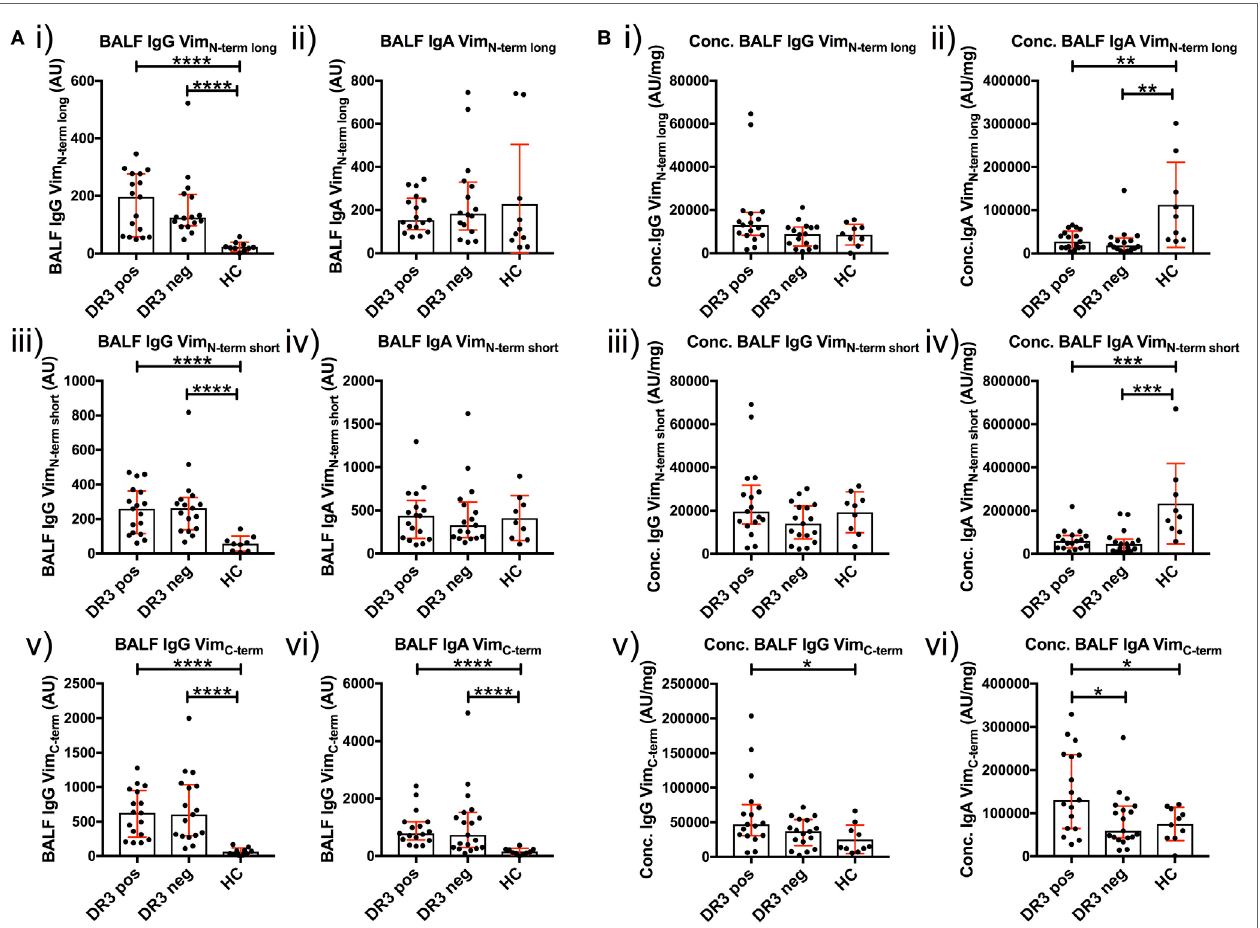
FigUre 6 | Bronchoalveolar lavage fluid (BALF) IgG and IgA titers to N- and C-terminal vimentin. Differences in BALF titers of IgG and IgA to long (Vim N-term long ) and short N-terminal (Vim N-term short ) and a C-terminal recombinant fraction (Vim C-term ) of vimentin, between sarcoid patient groups and healthy controls are given as neat values [Arbitrary units (AU)] [ (a) i–vi] and as concentrations of total immunoglobulin isotype (AU/mg) [ (B) i–vi]. Titer comparisons between the two patient groups and HC were performed using the non-parametric Mann–Whitney U test. Values are presented as median with interquartile range and statistical significances are denoted as two-tailed p -values as follows: * p < 0.05; ** p < 0.01; *** p < 0.001; and **** p <